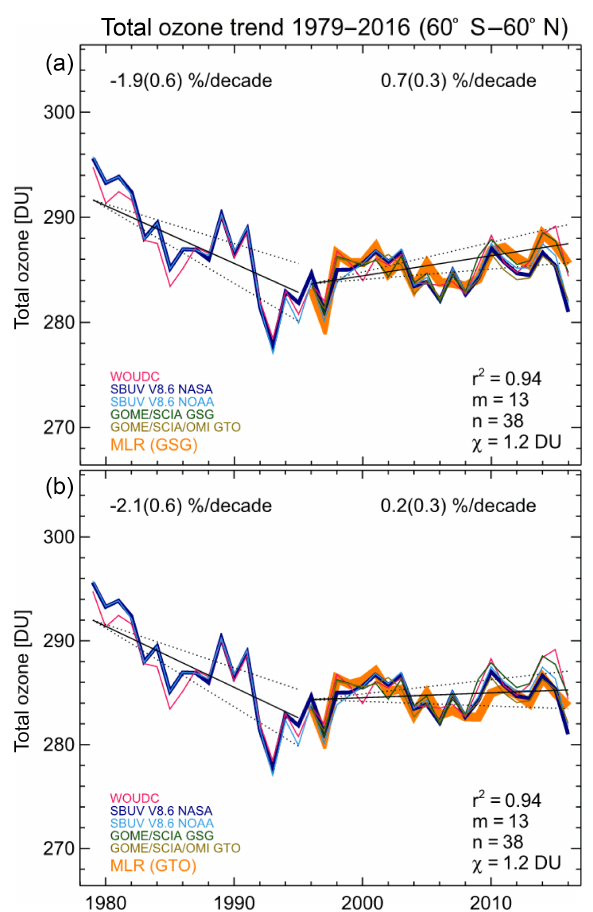
Figure 12. Near-global total ozone time series (60 ◦ S–60 ◦ N) and MLR time series (orange line) applied to GSG (a) and GTO (b) . Full MLR was applied including both BDC terms and